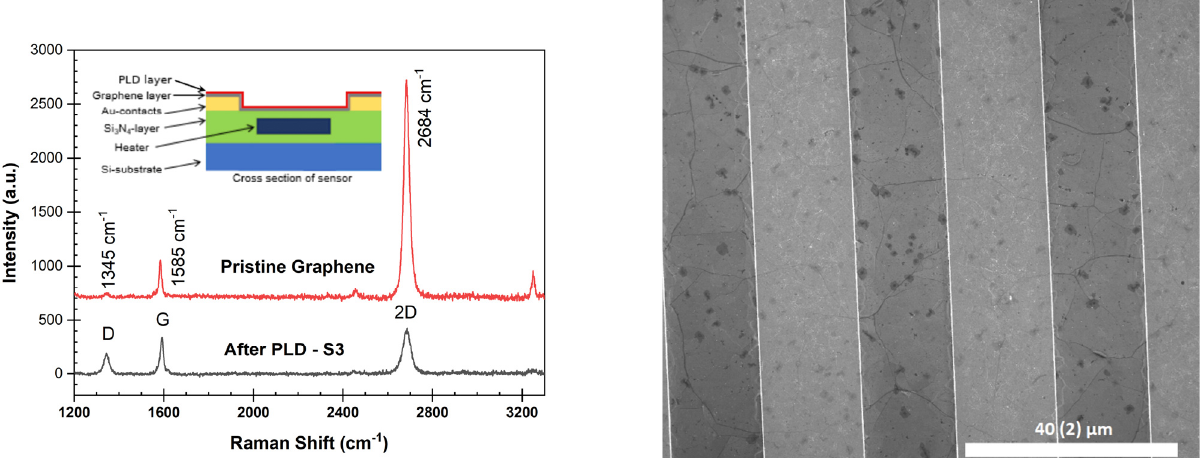
Figure 3. Left—Raman spectra of CVD graphene in sensor device, recorded before (pristine) and after PLD process (a.u. means arbitrary intensity units of the Raman instrument; the spectrum of pristine graphene is shifted upwards by 650 units). Inset: Scheme of the sensor based on PLD-functionalized CVD graphene on the micro-hotplate sensor substrate. Right—SEM image of single-layer graphene on top of interdigitated electrodes of the sensor substrate.